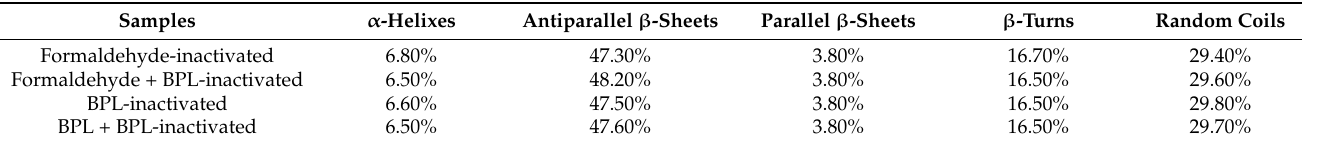
Figure 4. Circular dichroism (CD) spectroscopy analysis charts of different inactivated virus samples. ( A ) Formaldehyde ‐ inactivated virus samples. ( B ) Formaldehyde + BPL ‐ inactivated virus sam ‐ ples. ( C ) BPL ‐ inactivated virus samples. ( D ) BPL + BPL ‐ inactivated virus samples. Table 2. The percentage of secondary structure contents of different inactivated virus samples ob ‐ tained in the CD studies.